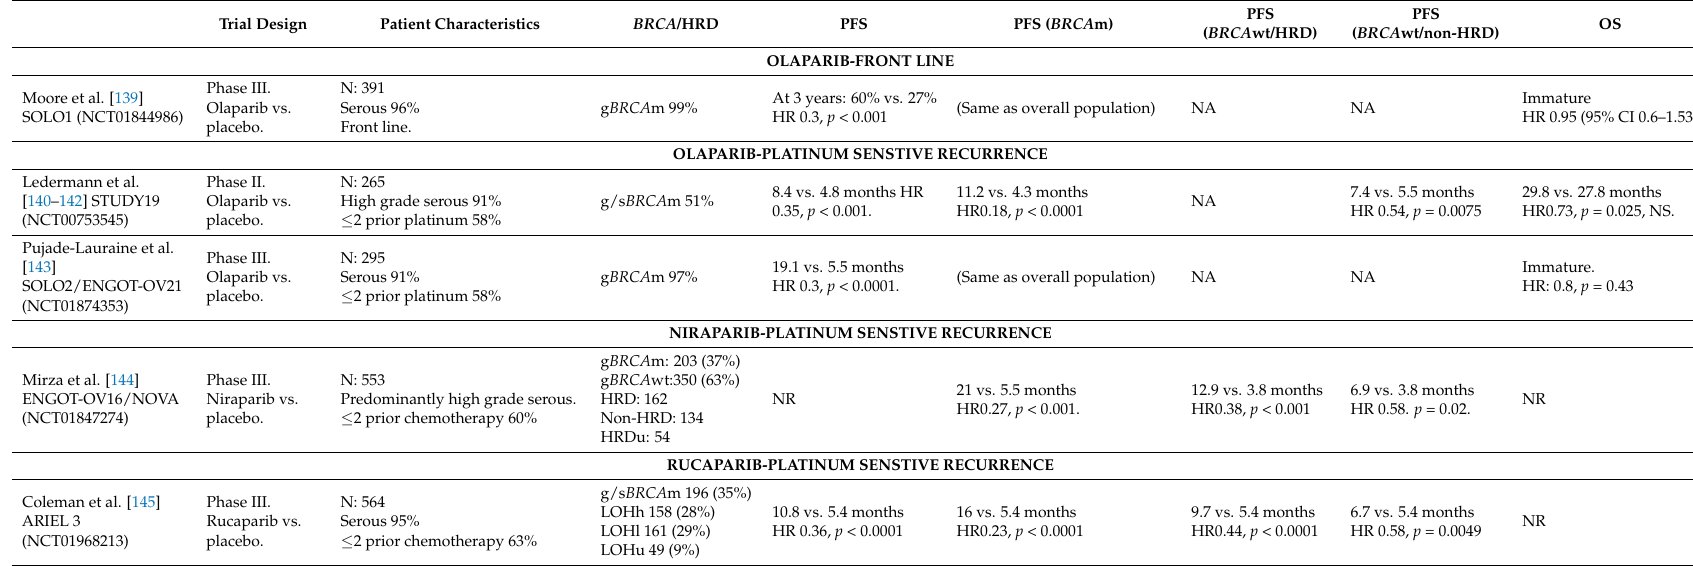
Table 2. Randomized double-blind phase II and III trials assessing maintenance PARPi, showing PFS benefit, irrespective of BRCA m status, and non-significant or immature OS data. HRD: Homologous recombination deficiency. Non-HRD: Non homologous recombination deficient. HRDu: Homologous recombination deficiency unkown. LOHh: High loss of heterozygocity, LOHl: Low loss of heterozygocity; LOHu: Unkown loss of heterozygocity. NA: Not applicable. NR: Not